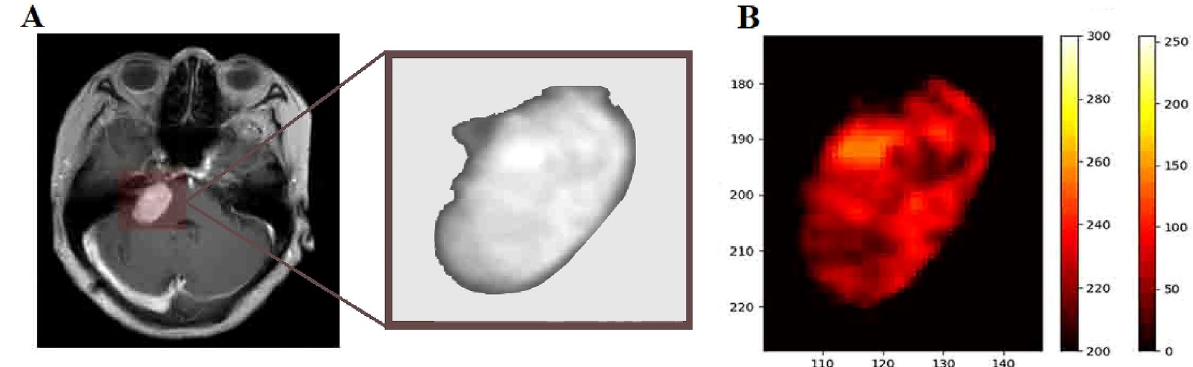
Figure 4. Pseudo-color map generated from ROI of T1-CE sequences. ( A ) T1-CE sequence after imaging preprocessing. ( B ) Pseudo-color map reflects the difference in the details of the grayscale within the ROI, which makes some details more